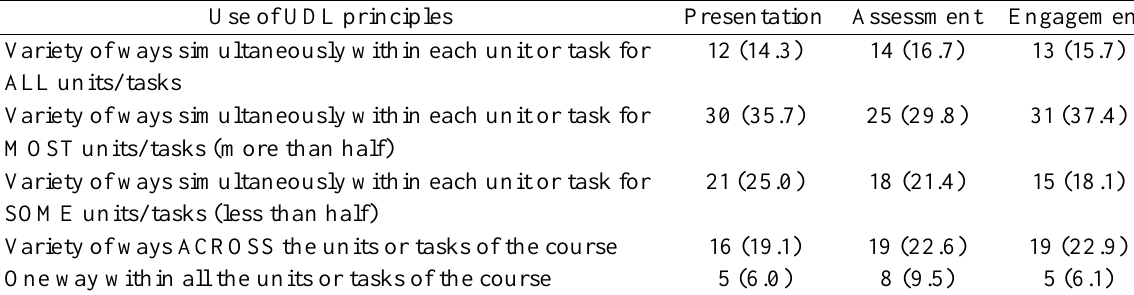
Table 8 Frequency (Percent) of Overall Use of UDL Principles Within the Course Use of UDL principles Presentation Assessment